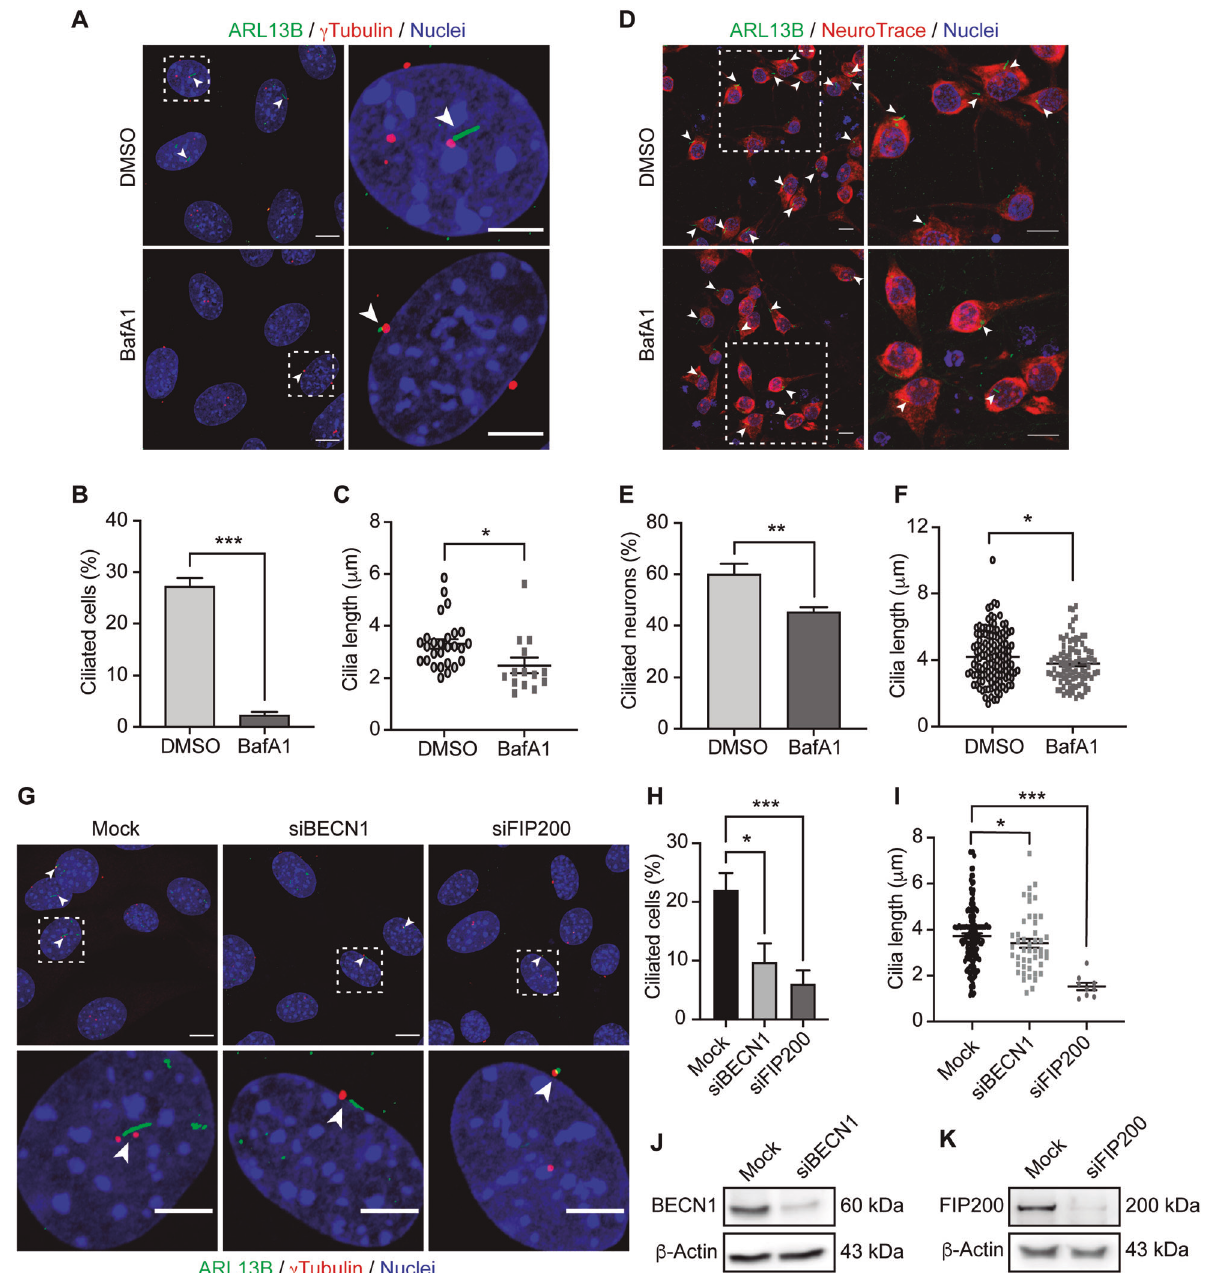
Fig. 3 Autophagy impairment decreases ciliated cell percentage and primary cilium length in hypothalamic neurons. A Representative confocal images of N43/5 hypothalamic neuronal cells treated with the autophagic fl ux inhibitor BafA1 (100 nM) or its vehicle (DMSO) for 6 h and then stained against ARL13B (ADP-ribosylation factor-like protein 13B, cilia axoneme) and γ -tubulin (cilia basal body). Arrowheads indicate the primary cilium. Scale bar: 10 µm. Inserts show a magni fi cation of one cell within the dotted square. Insert scale bar: 5 µm. Quanti fi cation of B percentage of ciliated cells and C cilia length of N43/5 hypothalamic cells treated as indicated in A . D Representative confocal images of primary hypothalamic neurons treated with DMSO or BafA1 (100 nM) during 6 h, stained against ARL13B and with the neuronal marker NeuroTrace, with their respective quanti fi cations ( E , F ). Inserts show a magni fi cation of cells within the dotted square. Arrowheads indicate the primary cilium. Scale bars: 10 µm. G Representative confocal images of N43/5 hypothalamic neuronal cells transfected with siRNA against BECN1 and FIP200. Scale bar: 10 µm. Inserts show a magni fi cation of one cell within the dotted square. Insert scale bar: 5 µm. Arrowheads indicate the primary cilium. Nuclei were stained with Hoechst (blue). Quanti fi cation of H percentage of ciliated cells and I cilia length of N43/5 hypothalamic cells treated as indicated in G . Representative western blot showing protein levels of N43/5 cells depleted of J BECN1 and K FIP200. Cells were incubated with Lipofectamine RNAiMAX reagent only (Mock) as control. Data are shown as mean ± SEM. Comparisons between two conditions were made using the unpaired two-tailed Student t -test. One-way ANOVA was used for comparison of more than 2 groups, followed by Tukey ’ s post hoc adjustment. * p < 0.05, ** p < 0.01, *** p < 0.001. n = 3.